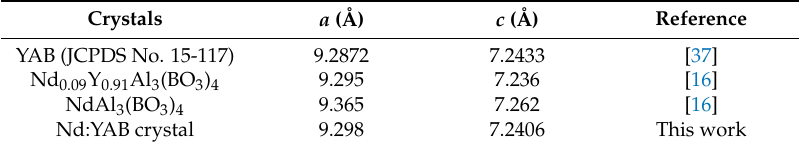
Table 1. Lattice parameters of YAl 3 (BO 3 ) 4.